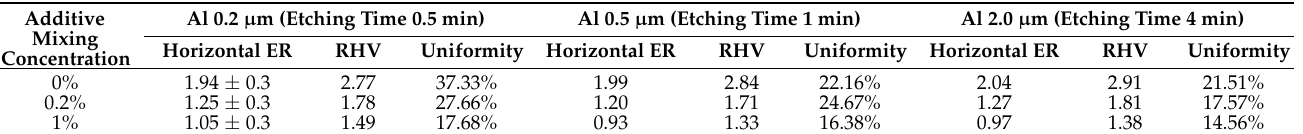
Table 1. Etching experiment results for horizontal etch rate (unit: µ m/min), RHV and uniformity.